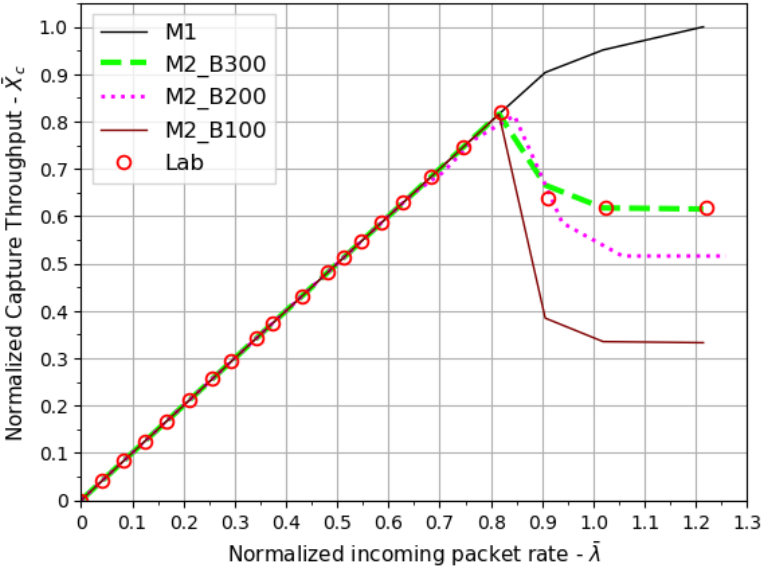
Figure 8. Results of normalized capture throughput for different budgets and scenario